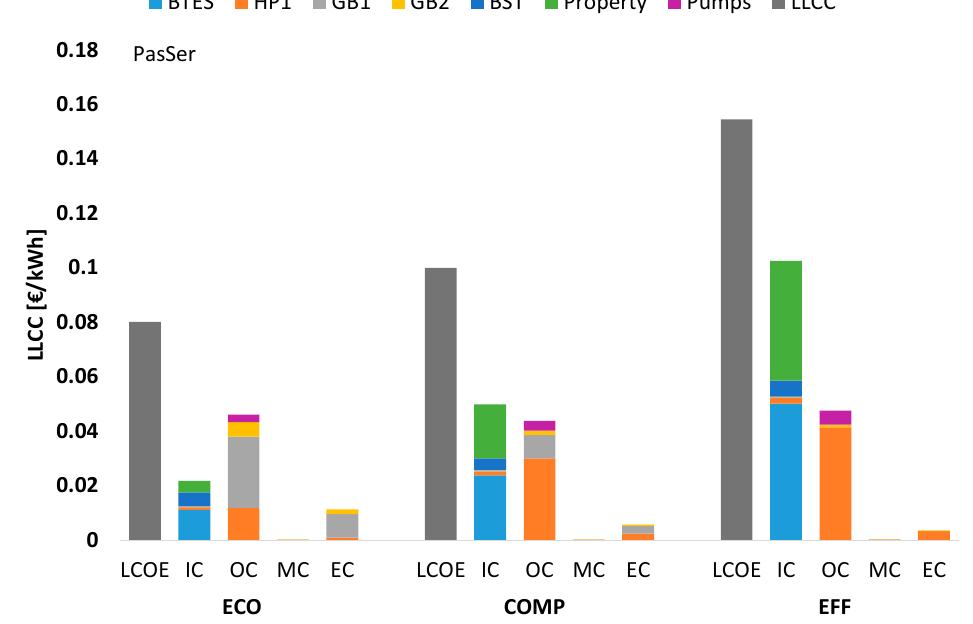
Figure 15. Total and component-wise Levelized Life Cycle Cost (LCOE) of PasSer scenario; LCOE is the summation of Initial Cost (IC), Operational Cost (OC), Maintenance Cost (MC) and Emission Cost (EC) for the economical (ECO), the compromise (COMP) and the most efficient (EFF) designs.